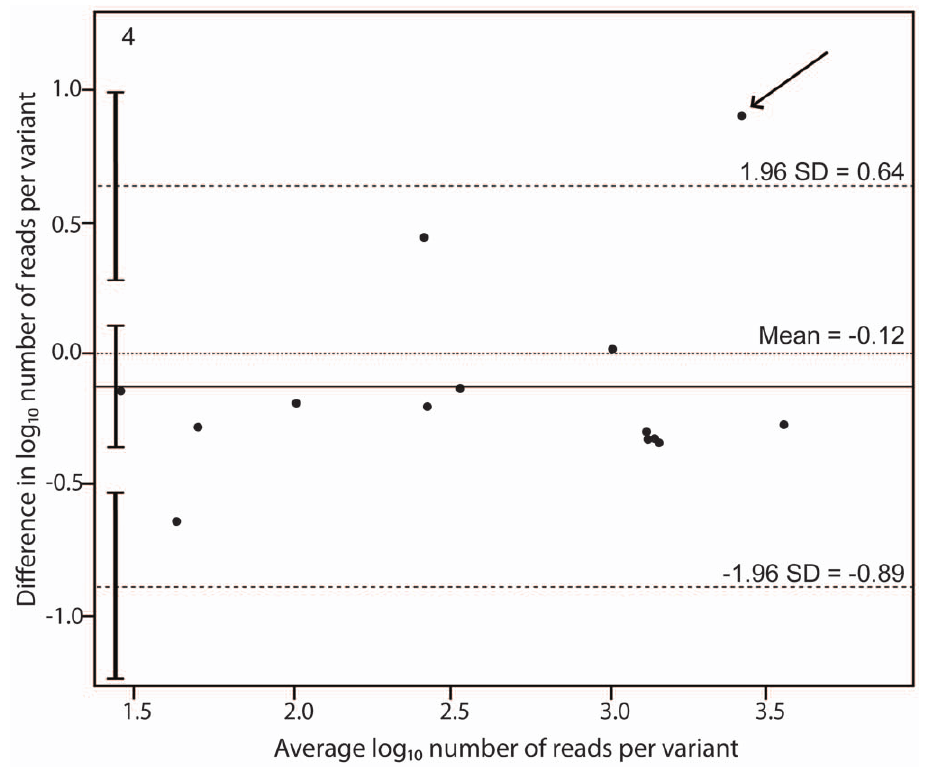
Figure 4. Bland-Altman plot showing the agreement of variant quantification using two primer sets. Templates for UDPS were prepared using original and alternative PCR primers. The number of reads in the second (alternative primers) measurement was weighted by the number of reads in the first measurement. The number of reads per variant was log transformed. The differences in number of reads per variant using the two primer sets are plotted against the average number of reads per variant. Horizontal lines are drawn at the mean difference between the two measurements and at the upper and lower limits of agreement. The 95% confidence intervals are also shown for the mean and the upper and lower limits of agreement.